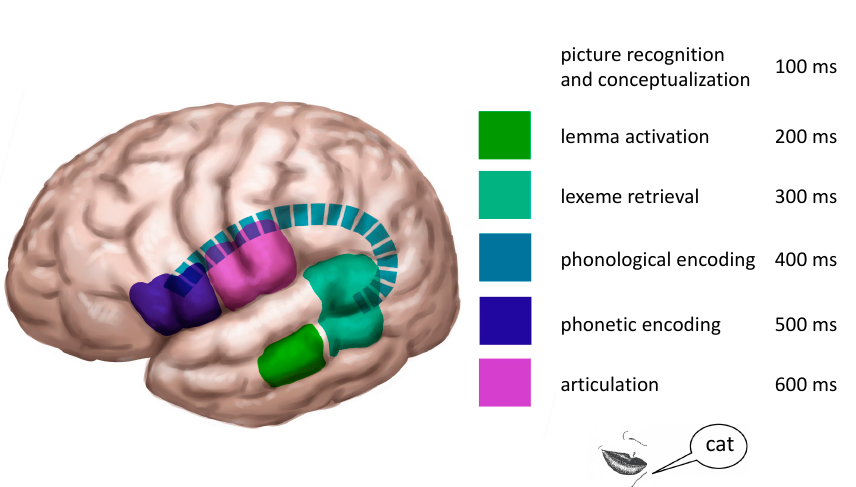
Figure 3. The timing process of object naming. Data based on Indefrey [3] and Den Hollander et al. [4]. ©Gert van Dijk.